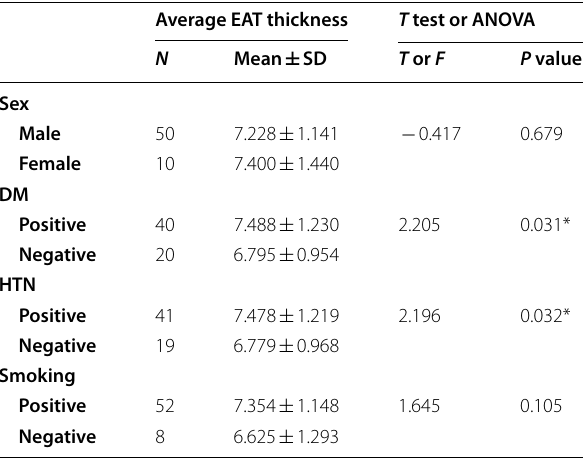
Table 5 Relationship between NAFLD fibrosis scoring system and sex of the patients and their comorbidities